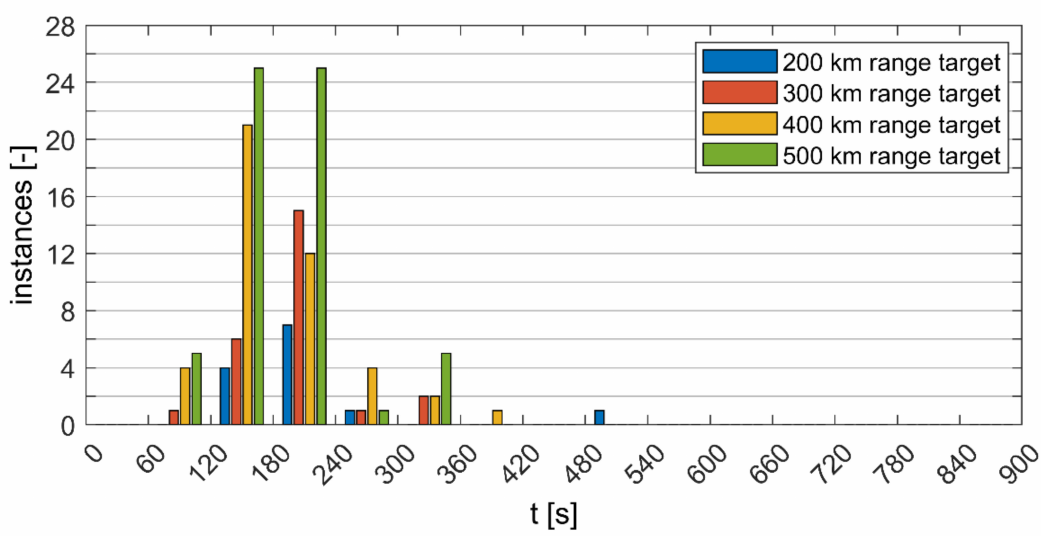
Figure A2. REX engagement instances binned by engagement time for FTP-75 and vehicle mass of 1800